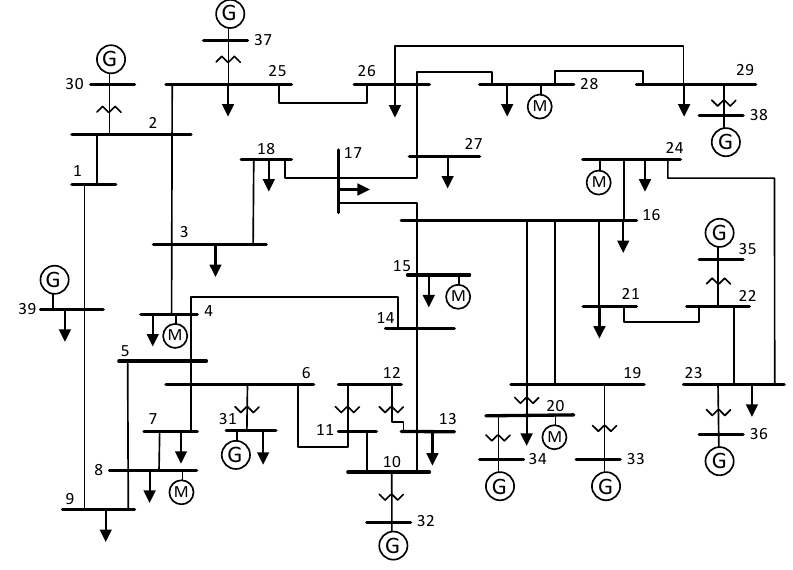
Figure 8. IEEE New England 39-bus system.